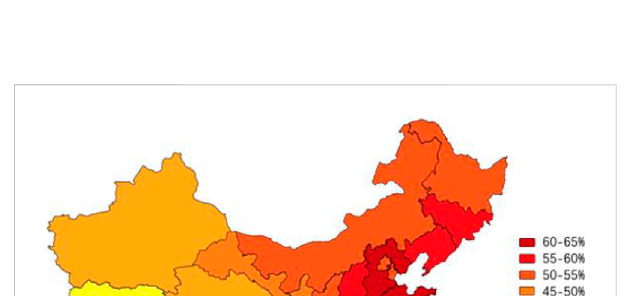
FIGURE 2 Vector map showing the T allele distribution of MTHFR C677T in Han ethnicity women.